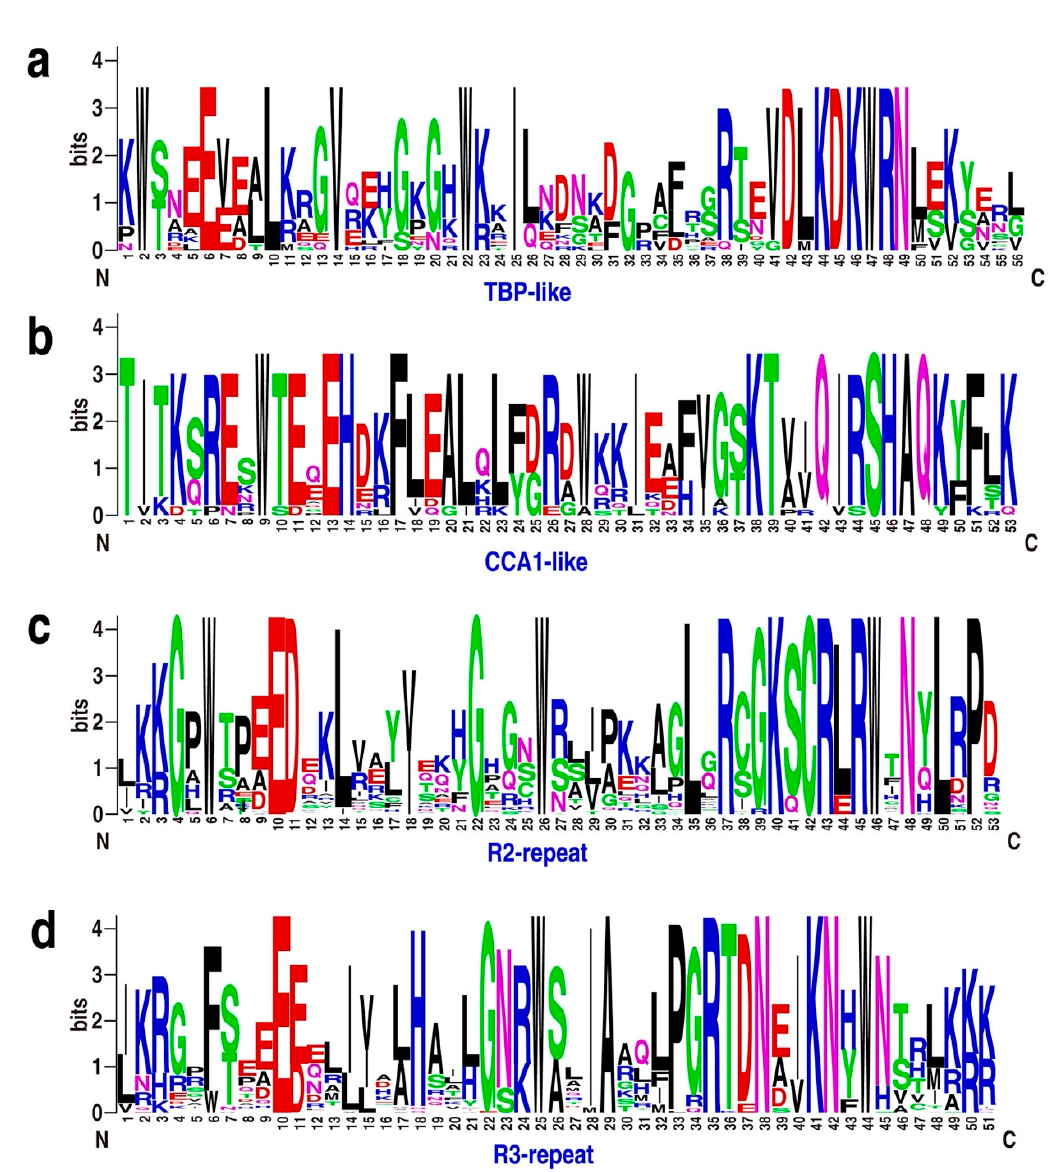
Figure 2. Sequence logos for the TBP-like ( a ), CCA1-like ( b ), R2 ( c ), and R3 ( d ) repeats found in Physcomitrella patens MYB proteins. Multiple alignment of 116 P. patens MYB domains was performed with MUSCLE software, and visualized by the web logo server. The bit score indicates the information content for each position in the sequence.